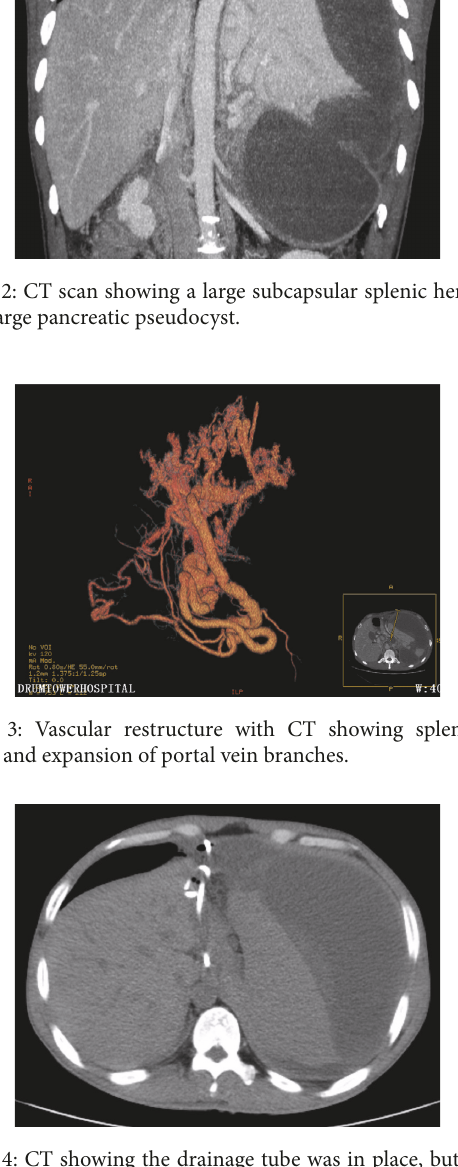
Figure 4: CT showing the drainage tube was in place, but splenic subcapsular hematoma had no